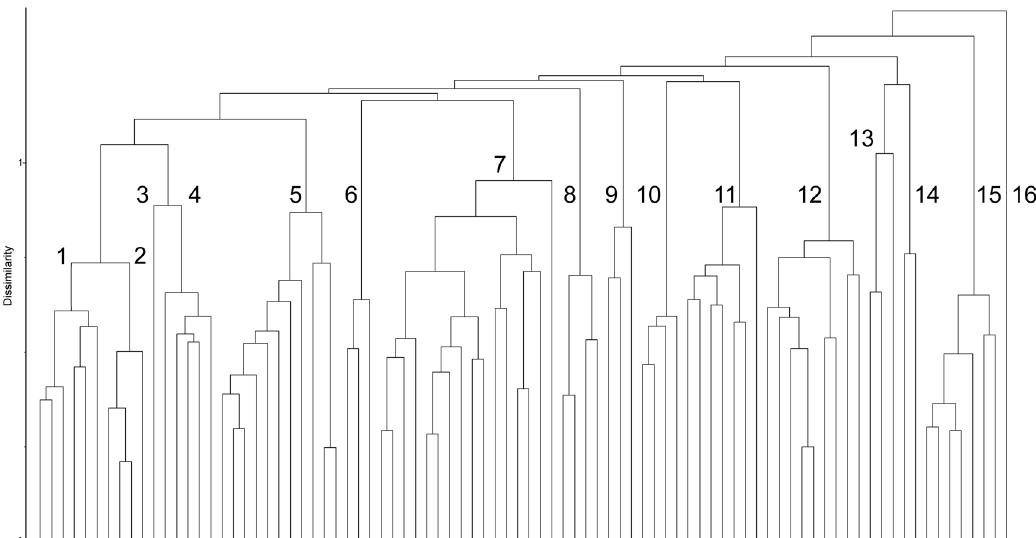
Figure 5. Cluster analysis of relevés of marsh and water edge pioneer annual vegetation (cover data, Chord distance, UPGMA): 1, Polygonetum hydropiperis , Persicaria hydropiper -dominated stands; 2, Leersietum oryzoidis , wetter stands with Persicaria hydropiper ; 3, Typhetum latifoliae ; 4, Leersietum oryzoidis , drier stands from lake margins; 5, Persicaria amphibia f. terrestre community; 6, Iri- detum pseudacori ; 7, Caricetum elatae ; 8, Glycerio-Sparganietum neglecti ; 9, Eleocharitetum palustris ; 10, Phalaridetum arundinaceae ; 11, Caricetum vesicariae ; 12, Schoenoplectetum lacustris ; 13, Polygonetum hydropiperis , Bidens frondosa -dominated stands from lake margins; 14, Cyperus fuscus community; 15, Phragmitetum australis ; 16, Beruletum erectae